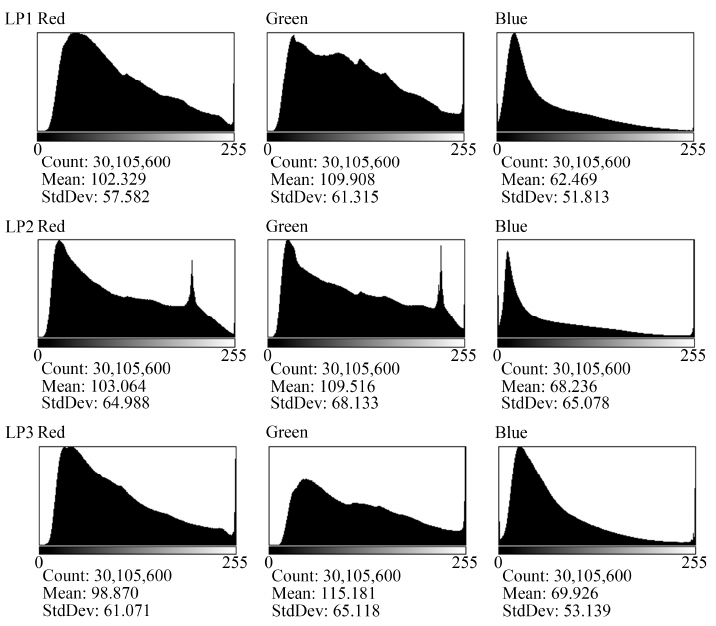
Figure 6. Color histogram of the low-preference landscape. Note: LP1, LP2 and LP3 refer to broadleaf forest 1, broadleaf forest 2 and broadleaf forest 3 in the low-preference landscape, respectively. The horizontal axis of the histogram represents the brightness partition of the landscape, and the vertical axis represents the number of pixels of color. The graphics software is ImageJ v1.8.0.112. This figure was created by the author.